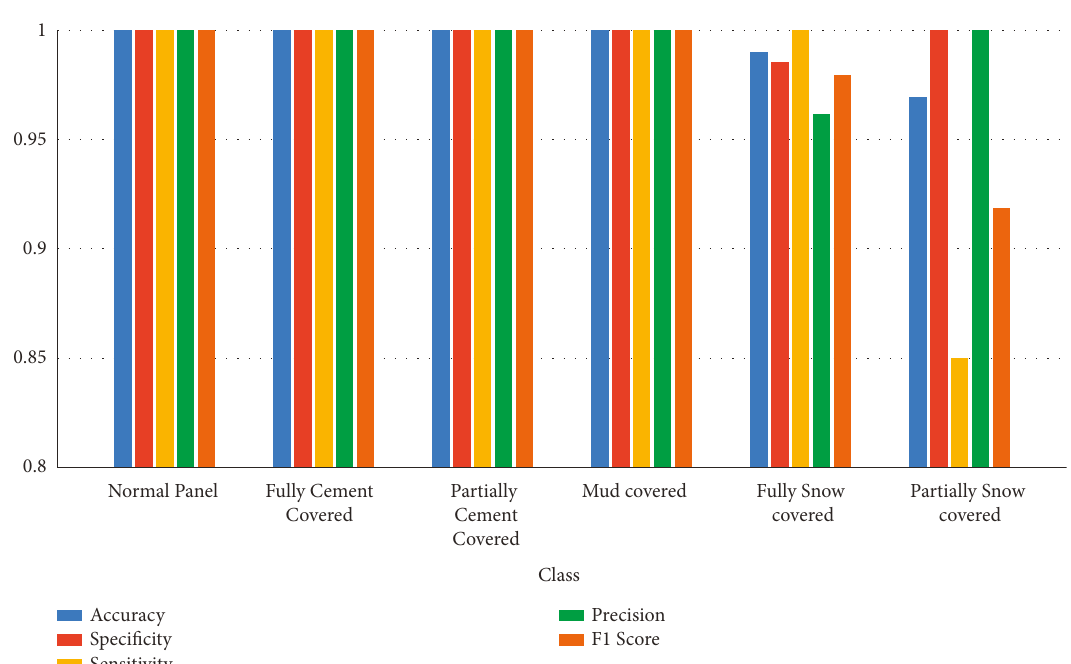
Figure 15: Statistical measure for